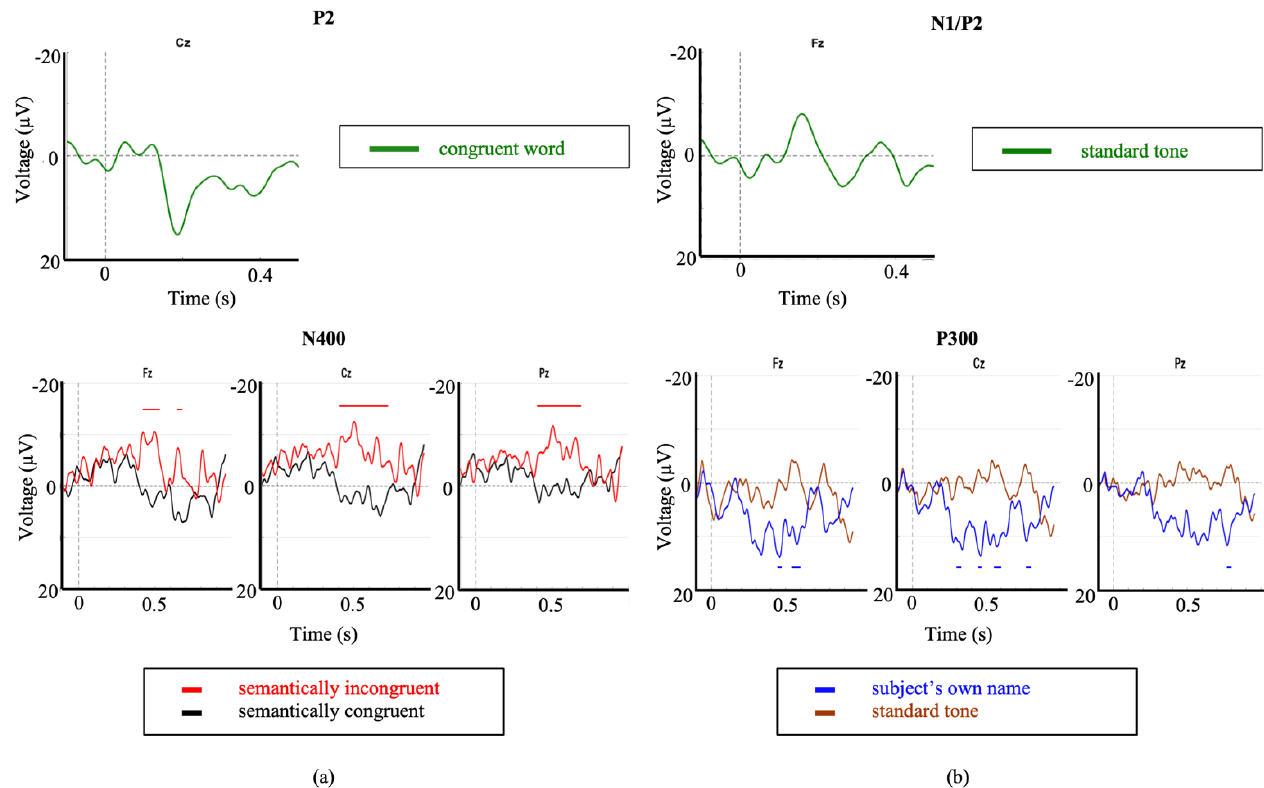
Figure 6. Event related potentials corresponding to Case Study 1 and Case Study 2. Exogenous ERPs were observed in response to: ( a ) the congruent word stimuli as part of the auditory PPVT-R paradigm (P2), and ( b ), the standard tone of the Modified Fischer paradigm (N1/P2). Significant differences were observed (significant intervals indicated by color-matched bars) for brain responses to ( a ) the SVS paradigm in the first case study, and ( b ) SON as part of the modified Fischer paradigm in the second case study.